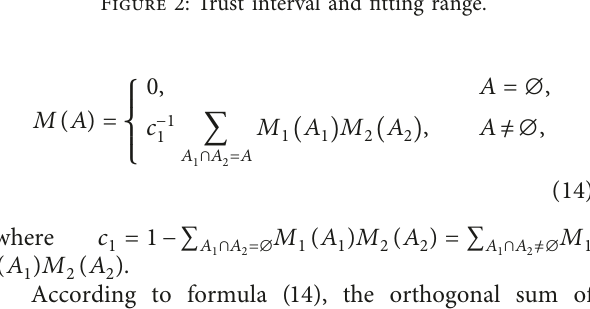
Figure 2: Trust interval and fitting